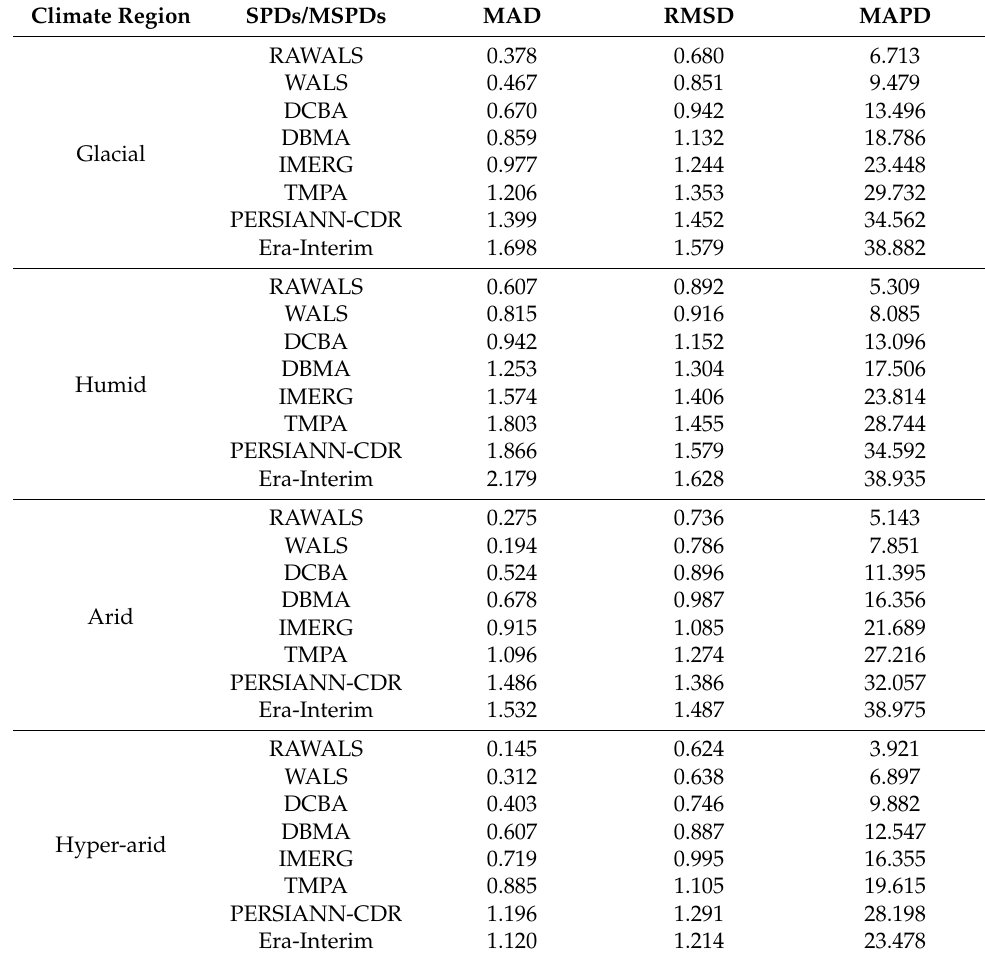
Table 6. Performance assessment of SPDs/MSPDs on a regional scale using SPI-12 estimated from RGs as a